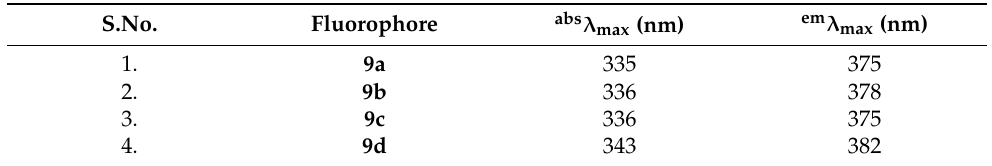
Table 3. Photophysical properties of naphthalimide analogs 9a – d in acetonitrile at a concentration of 1 × 10 −6 M.